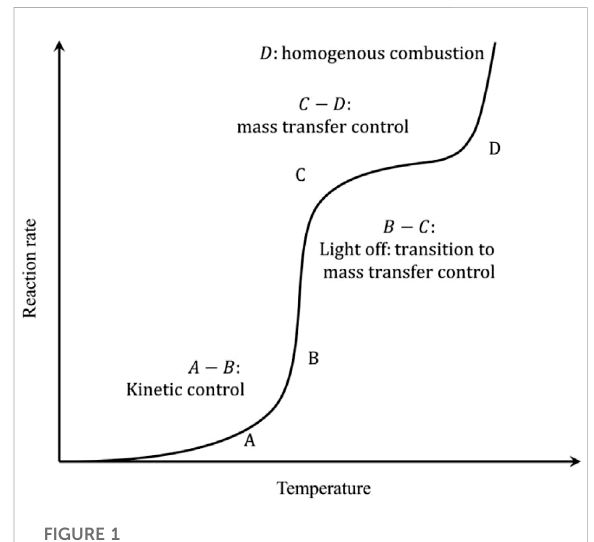
FIGURE 1 The reaction rate of CMC as a function of